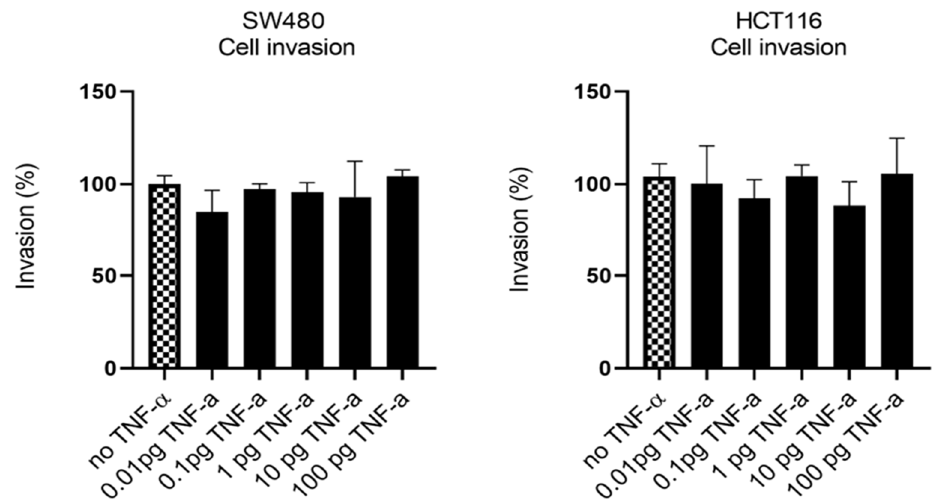
Figure 7. Cell invasion in response to TNF- α treatment in SW480 and HCT116 cells. Cells were treated with a dose range of TNF- α (0.01–100 pg/mL). Cell invasions were determined using transwell Matrigel inserts and alamarBlue assay to assess invading cell numbers. Data are expressed as (%) compared to vehicle control (no TNF- α ). Significant difference was calculated using one-way ANOVA followed by Dunnett’s test (GraphPad Prism 8). Error bars represent the SEM for three independent cultures.